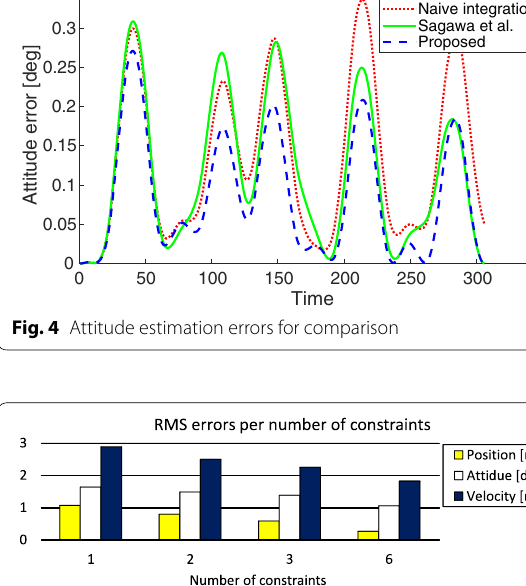
Fig. 5 RMS errors with different number of constraints (simulated data)